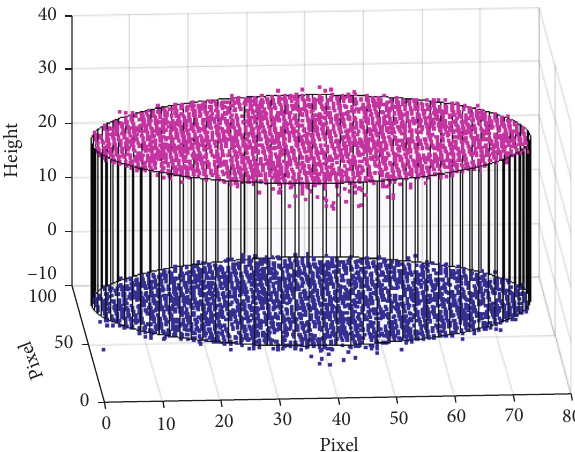
Figure 14: Point clouds of transparent material.